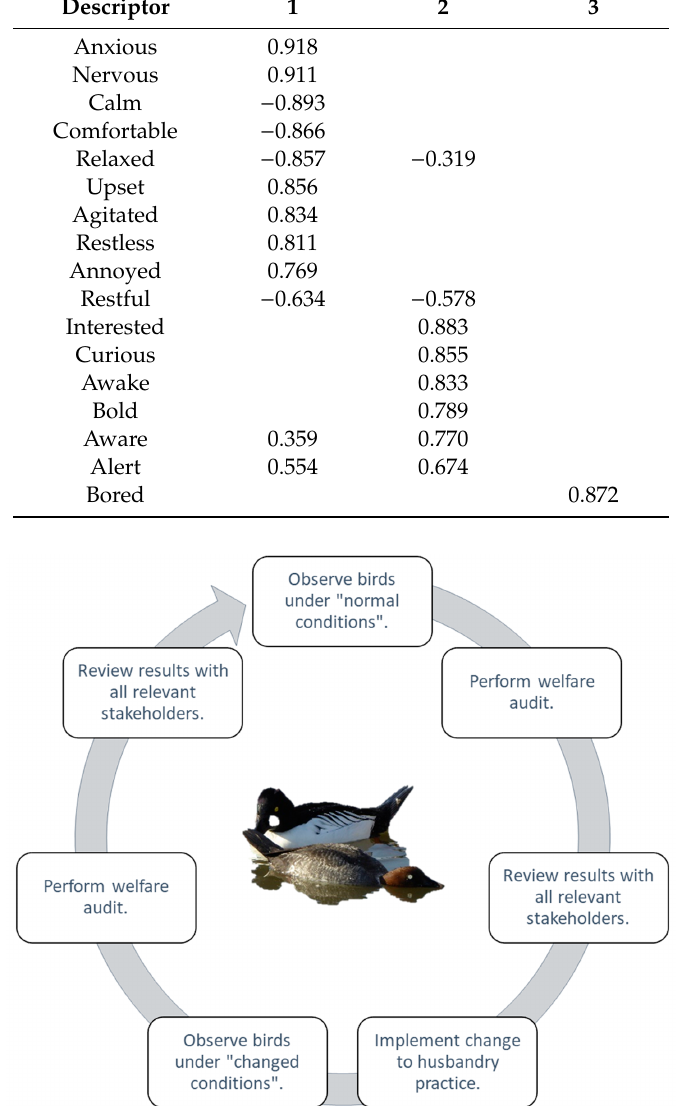
Table 3. Rotated components matrix showing the factor loadings for each